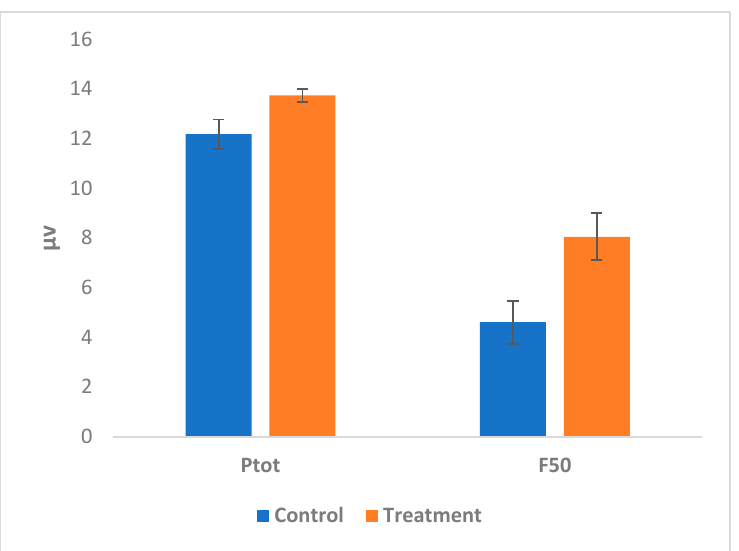
Figure 4. Differences in Ptot and F50 electroencephalogram RMS in goats upon exposure to act of slaughter. (Ptot—total power of EEG spectrum; F50—median frequency of EEG spectrum, Control— state without exposure to act of slaughter, Treatment—state during the exposure to act of slaughter).